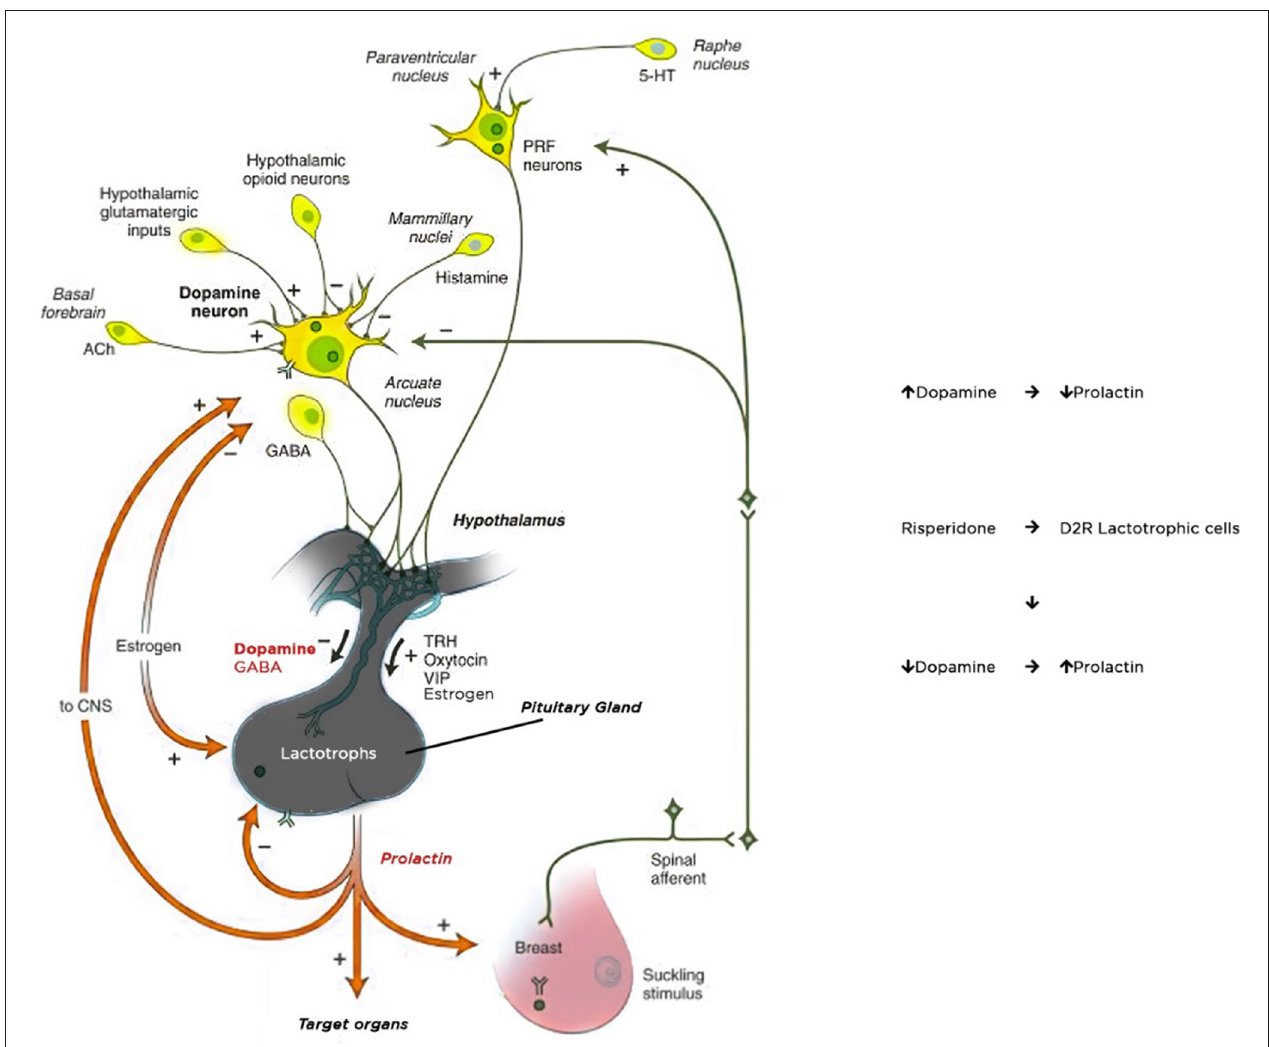
FIGURE 1 | Mechanism of prolactin secretion and